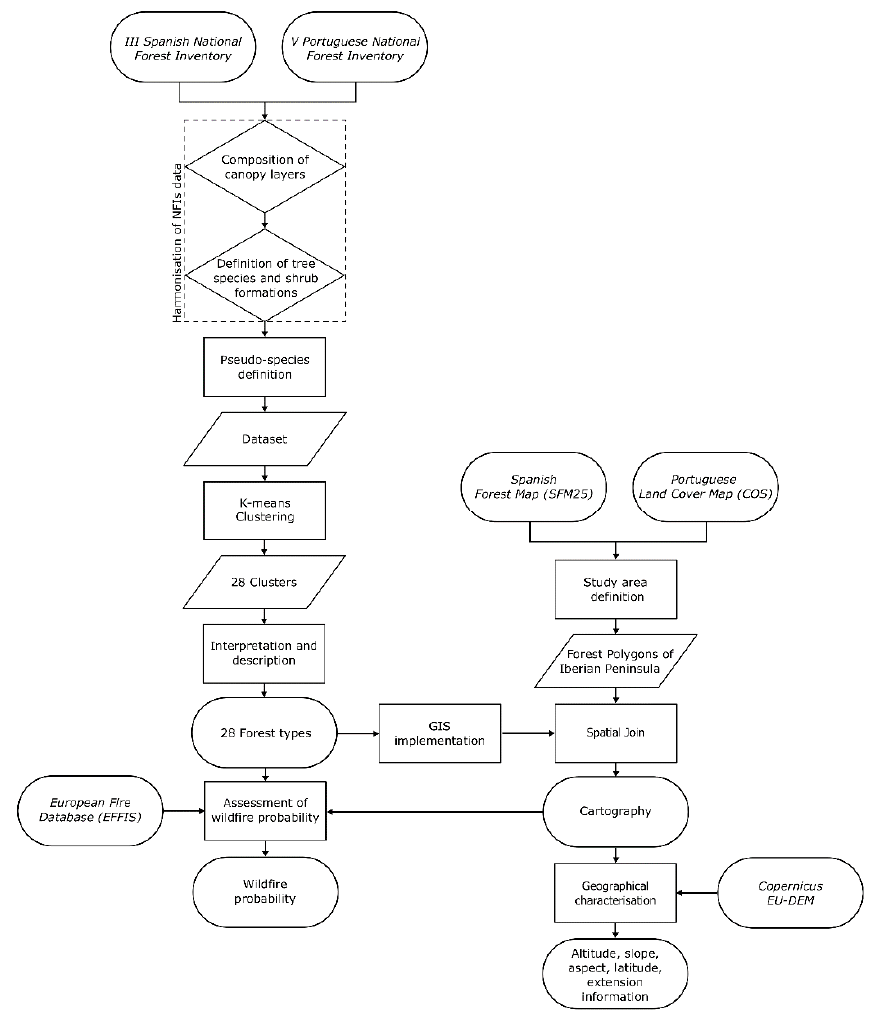
Figure 3. Workflow and data sources for the establishment of forest types in the Iberian Peninsula.